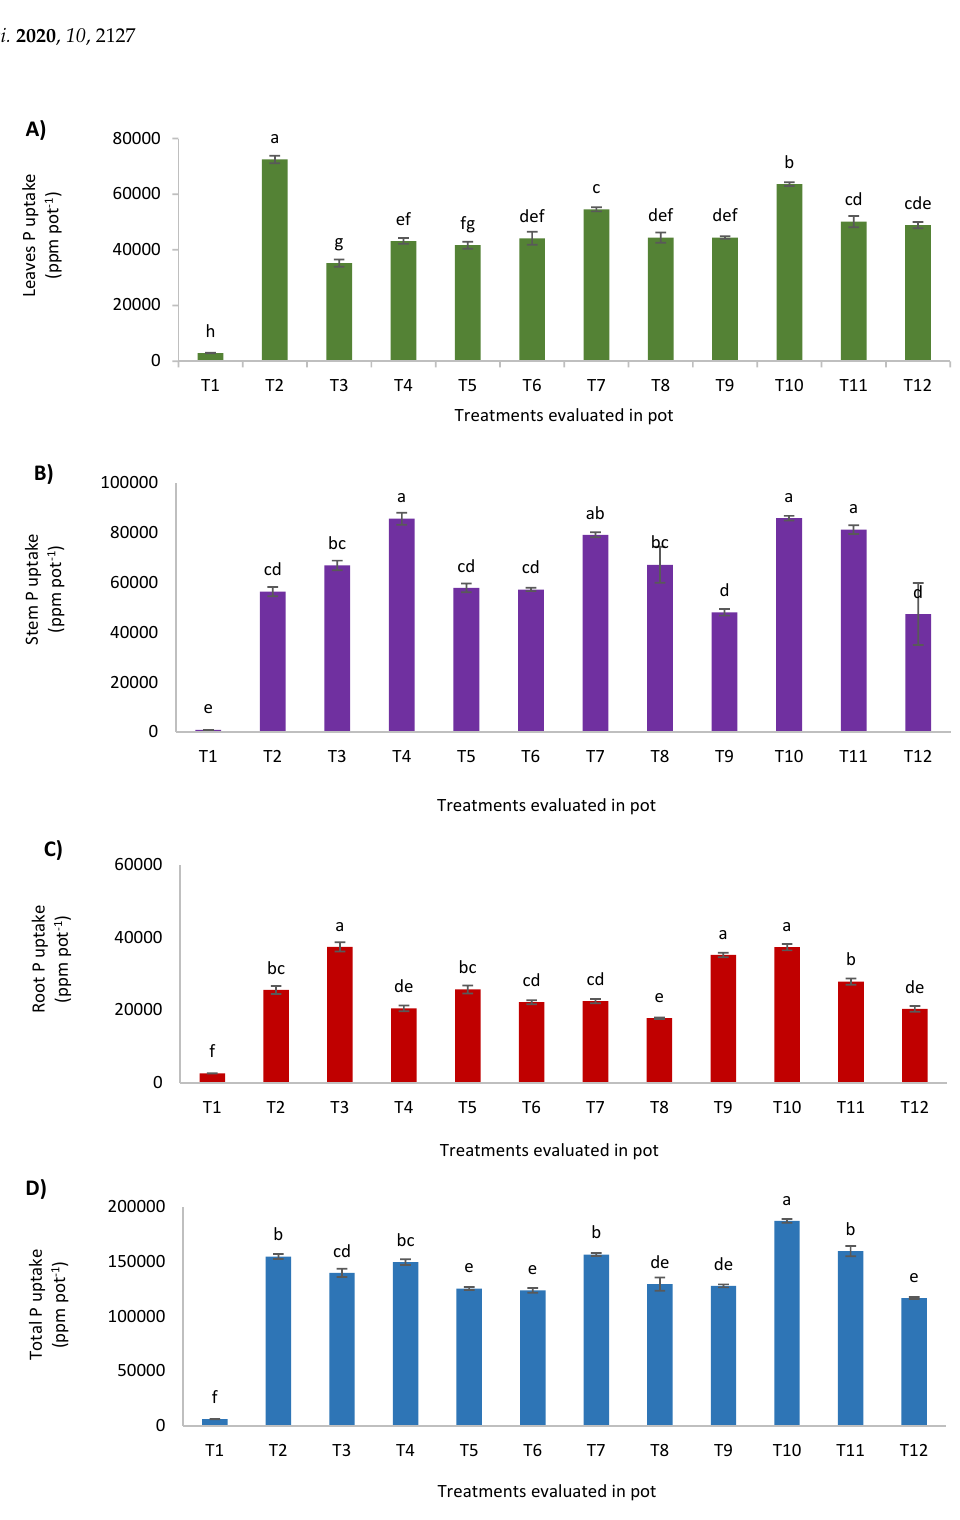
Figure 4. Effects of treatments on P uptake of ( A ) leaves; ( B ) stems; ( C ) roots; and ( D ) total P uptake of maize at tasseling stage. Different letters indicate significant difference between means using Tukey’s HSD (Honestly Significant Difference) test at p ≤ 0.05. The error bars are the ± standard error of triplicates.